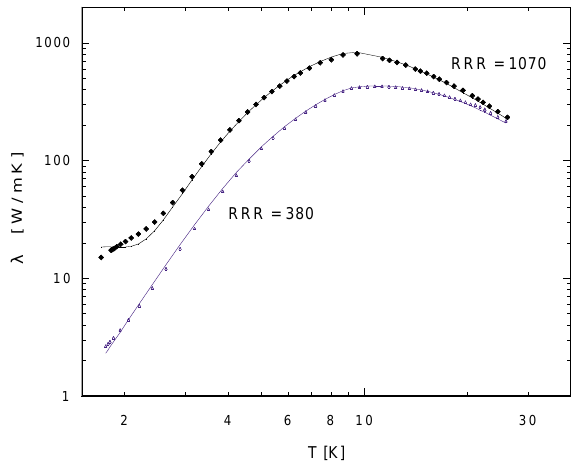
FIG. 2. The measured heat conductivity in niobium as a func- tion of temperature [8]. Continuous curves: parametrization by Bonin, using the RRR and the average grain size as input parameters [9]. These data do not show an enhancement at 2 K (the so-called “phonon peak”) which was observed in some earlier experiments [5].